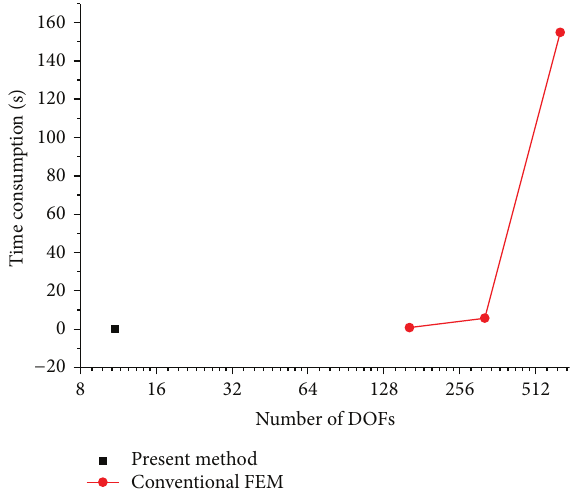
Figure 6: Time consumption comparison of center deflection for clamp supported beam under uniform load stochastic